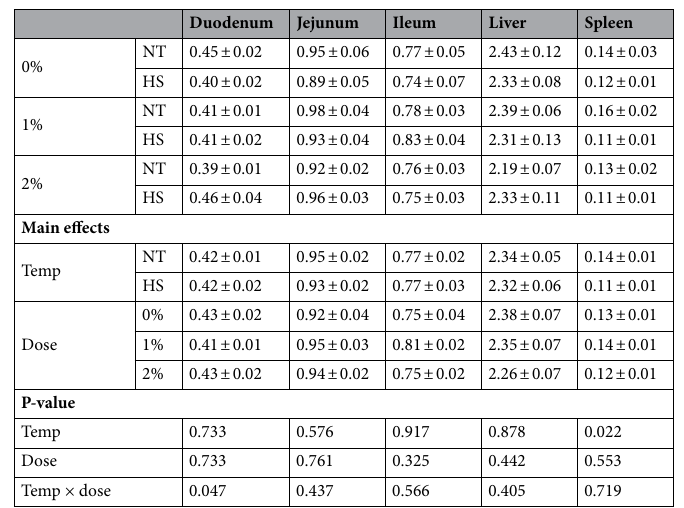
Table 4. Effect of dietary steam-exploded pine particle supplementation on the relative organ weight (percent body weight) of broilers reared under normal or cyclic heat stress conditions. NT thermoneutral temperature, HS heat stress. Values are presented as mean with standard error (n = 7).